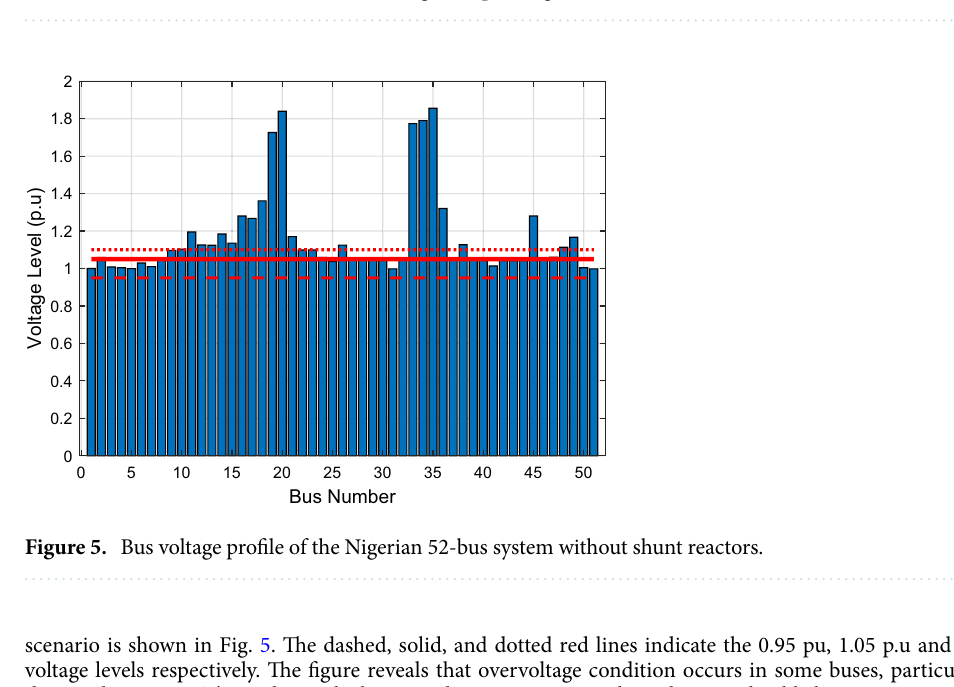
Table 1. Load data of the 52-bus 330 kV Nigerian power grid.